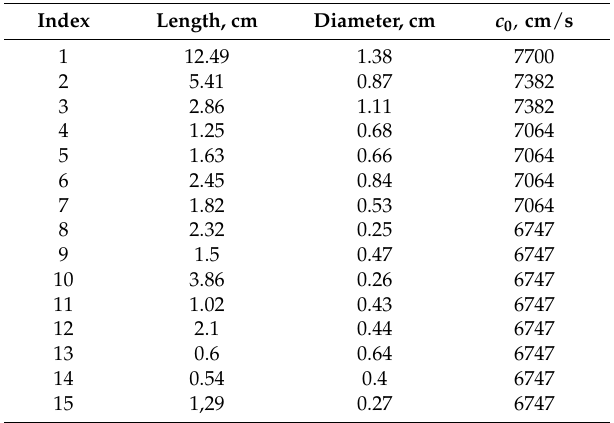
Table A2. Parameters of the 1D structure of the tracheobronchial tree (Figure